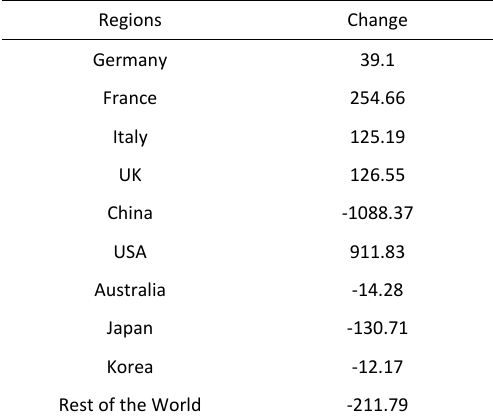
Table 2: Change in trade balances (millions of dollars) Regions